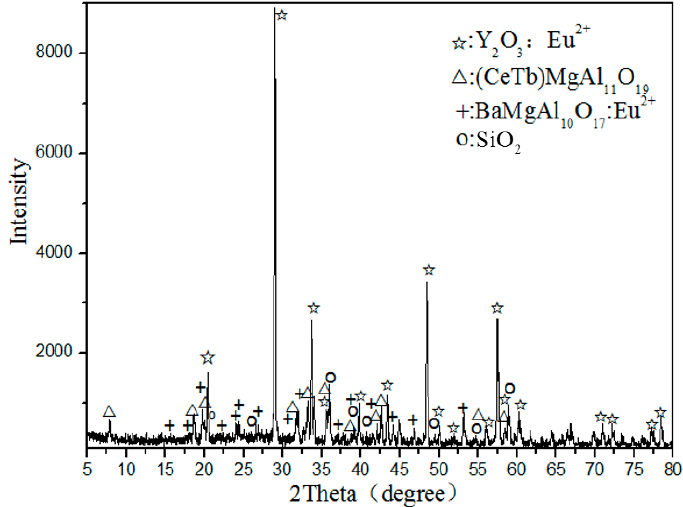
Figure 1. XRD analysis of waste phosphor.